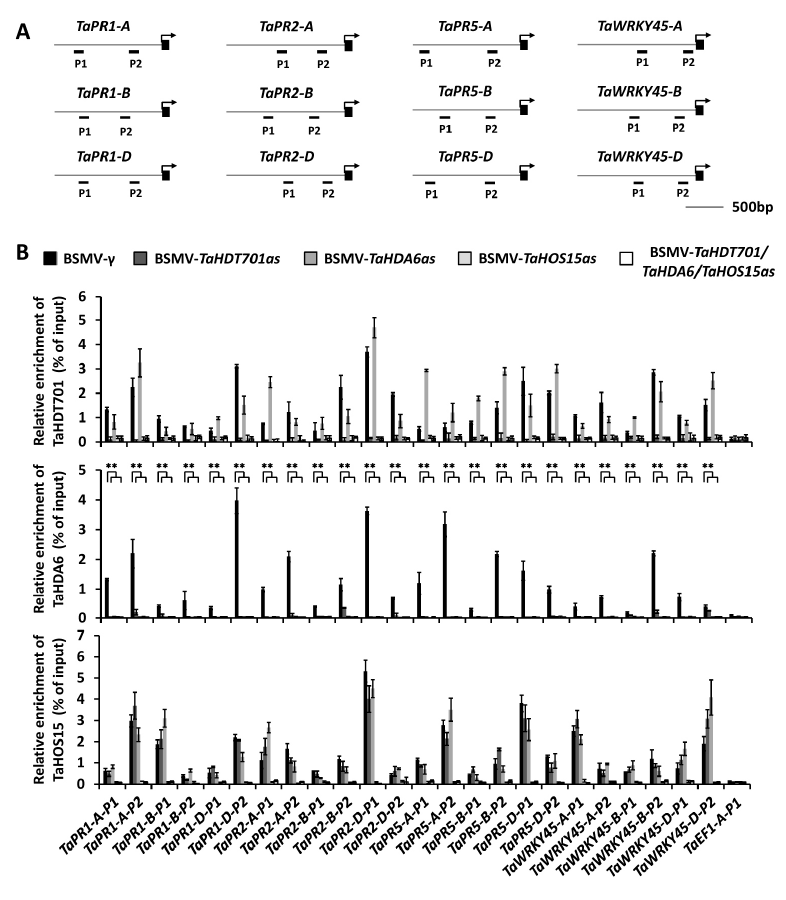
Figure 5. Distribution of TaHDT701, TaHDA6, and TaHOS15 at chromatins of TaPR1 , TaPR2 , TaPR5 , and TaWRKY45 in different backgrounds. ( A ) Schematic diagram of TaPR1 , TaPR2 , TaPR5 , and TaWRKY45 genes. Fragments for chromatin immunoprecipitation (ChIP)-qPCR analysis were labeled with numbers. ( B ) The binding of TaHDT701 (upper panel), TaHDA6 (middle panel), and TaHOS15 (lower panel) on the promoter of TaPR1 , TaPR2 , TaPR5 , and TaWRKY45 in wheat protoplasts analyzed by ChIP-qPCR on wheat plants with different background. The antibodies used for immunoprecipitation are indicated on each graph. The fragments employed for ChIP-qPCR analysis are indicated in Figure 5A. The data are means (±SE) from three independent biological repeats and were analyzed using Student’s t-test: ** p < 0.01.